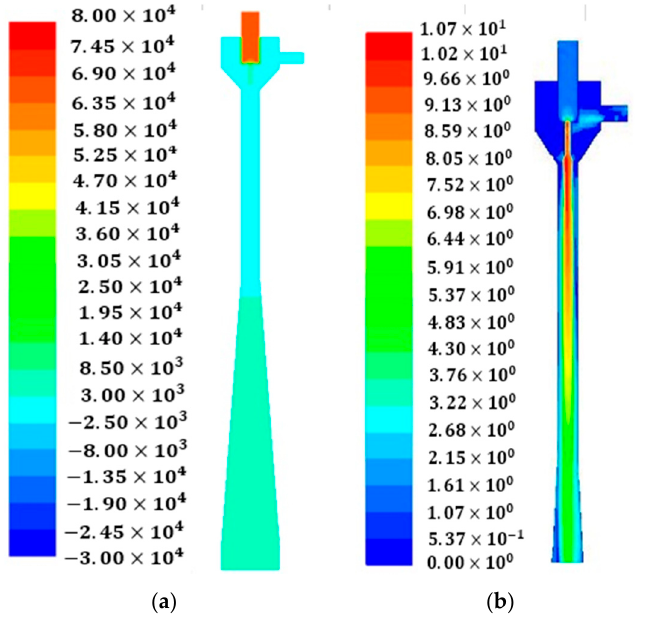
Figure 9. ( a ) The pressure contour [Pag], ( b ) the velocity contour [m/s].